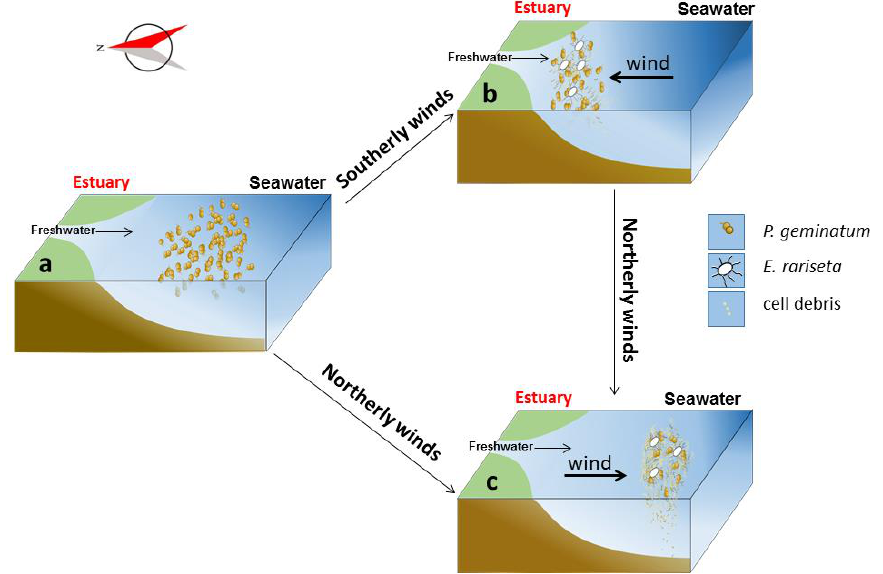
Figure 5. Conceptual pattern of Polykrikos geminatum bloom dynamics in the Pearl River Estuary. ( a ) High abundance of P. geminatum depicts the bloom in favorable weather conditions, ( b ) continuous and strong southerly winds drive P. geminatum bloom water masses to the inner estuary, and ( c ) northerly winds drive P. geminatum bloom water masses to the outer estuary. In high-salinity waters, P. geminatum cells break, and the bloom disintegrates. Changes in the environmental conditions shown in ( a , b ) are related to variations in the wind direction and seawater incursion. Conditions ( a ) and ( b ) change to ( c ) under the influence of northerly winds, freshwater input, and high salinity.